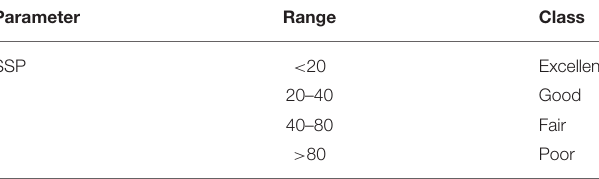
TABLE 6 | Classification of groundwater quality based on SSP. Parameter